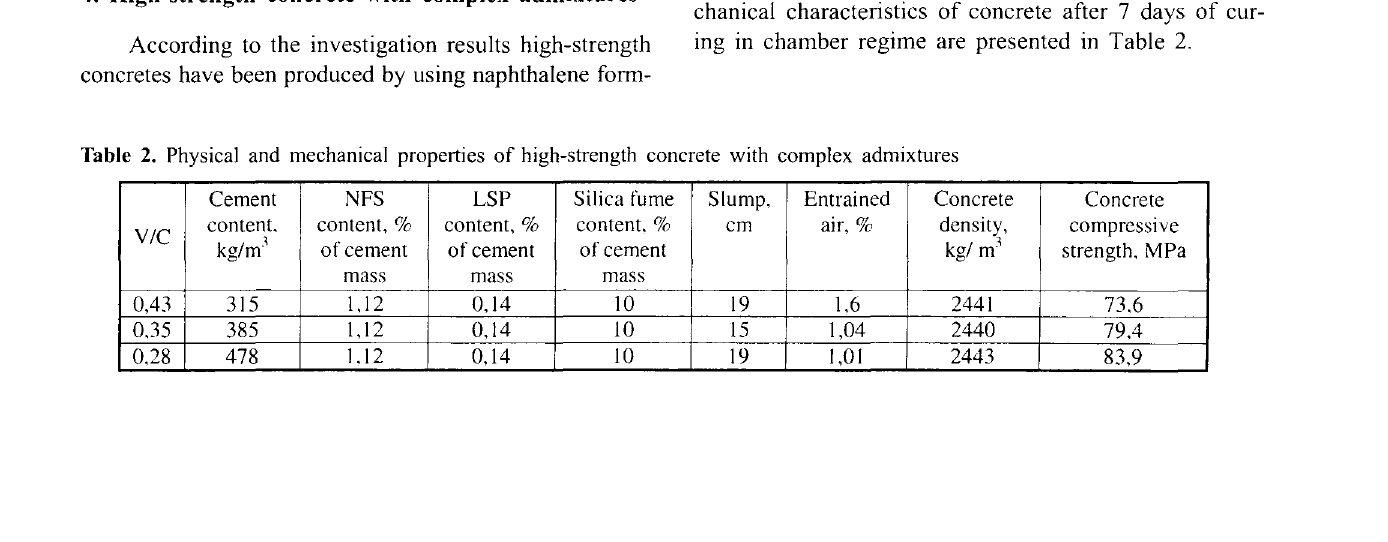
Table 2. Physical and mechanical properties of high-strength concrete with complex admixtures Cement NFS LSP Silica fume Slump, Entrained Concrete Concrete